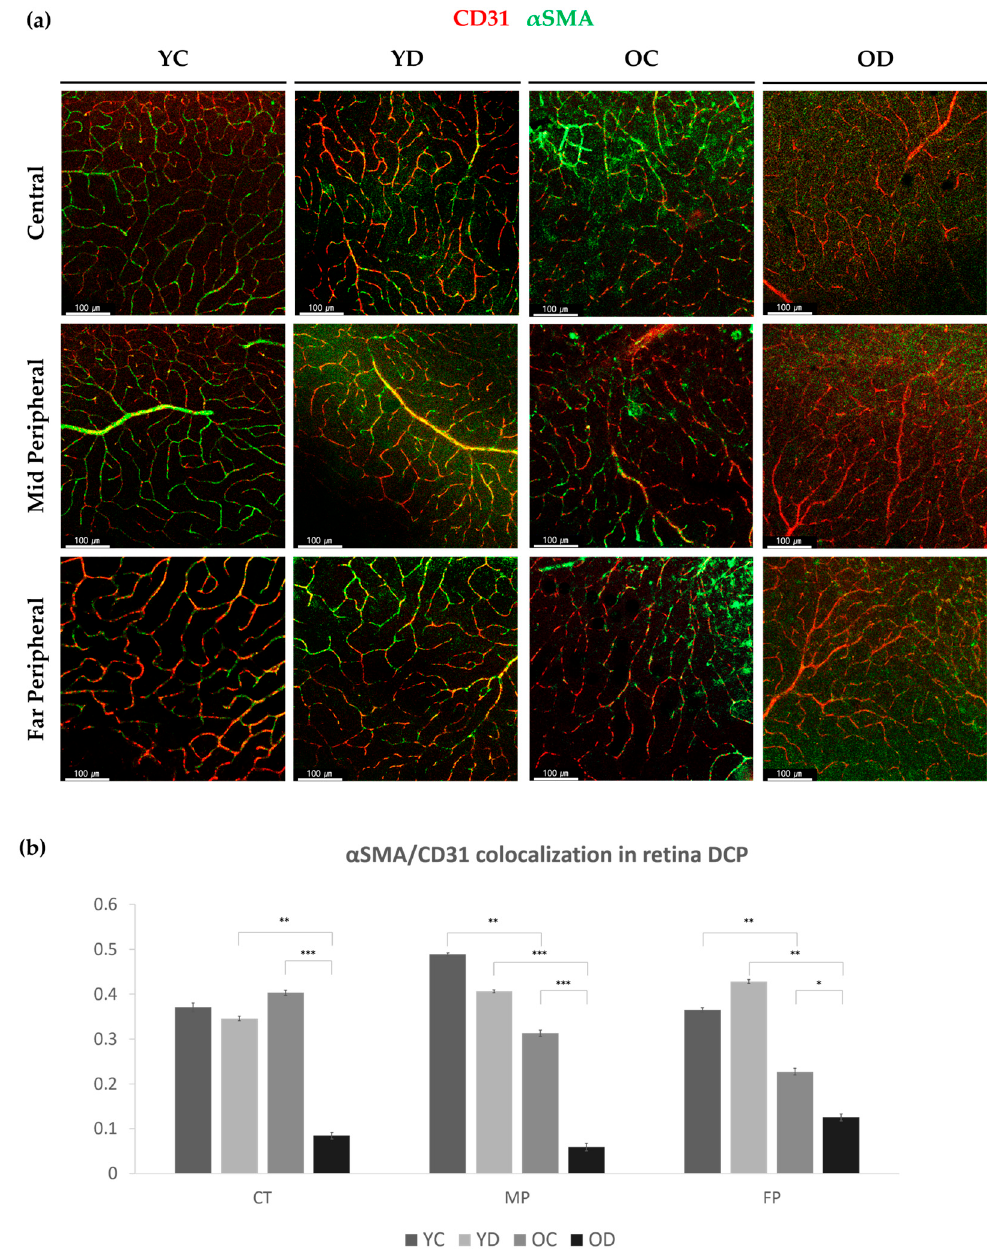
Figure 3. Deep capillary α SMA positive perivascular cells in the diabetic retina. ( a ) Regional distribution difference in retinal deep vessel α SMA ensheathment at the central area, mid-peripheral area and far-peripheral area in YC (Young Control), YD (Young Diabetes), OC (Old Control), and OD (Old Diabetes). ( b ) For each of the groups and regions, α SMA colocalized over CD31 was measured with the Manders coefficient. Note that OD showed significantly reduced α SMA coverage at every region compared to either YD or OC. 4 different samples were analyzed and averaged per condition. Error bars indicate standard deviations (1-way Anova; N = 16 per group, * p < 0.05, ** p < 0.01, *** p < 0.001) .